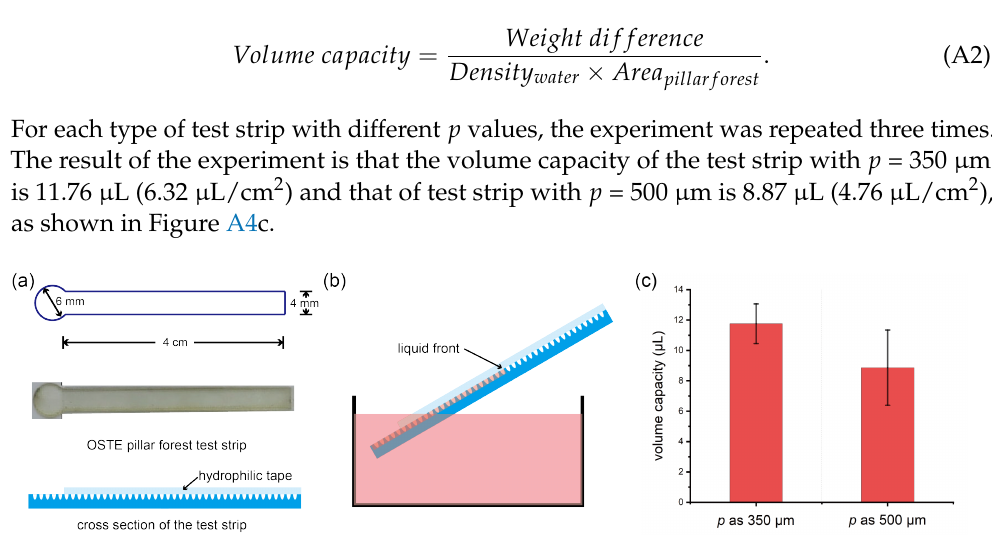
Figure A4. Water absorption experiments on the OSTE pillar forest substrate. ( a ) The design of test strips of OSTE pillar forest (up), the picture of a test strip (middle), and the schematic of the cross section of the test strip (below). ( b ) The schematic of the experimental setup. ( c ) The comparison of water volume absorbed on test strips with different p